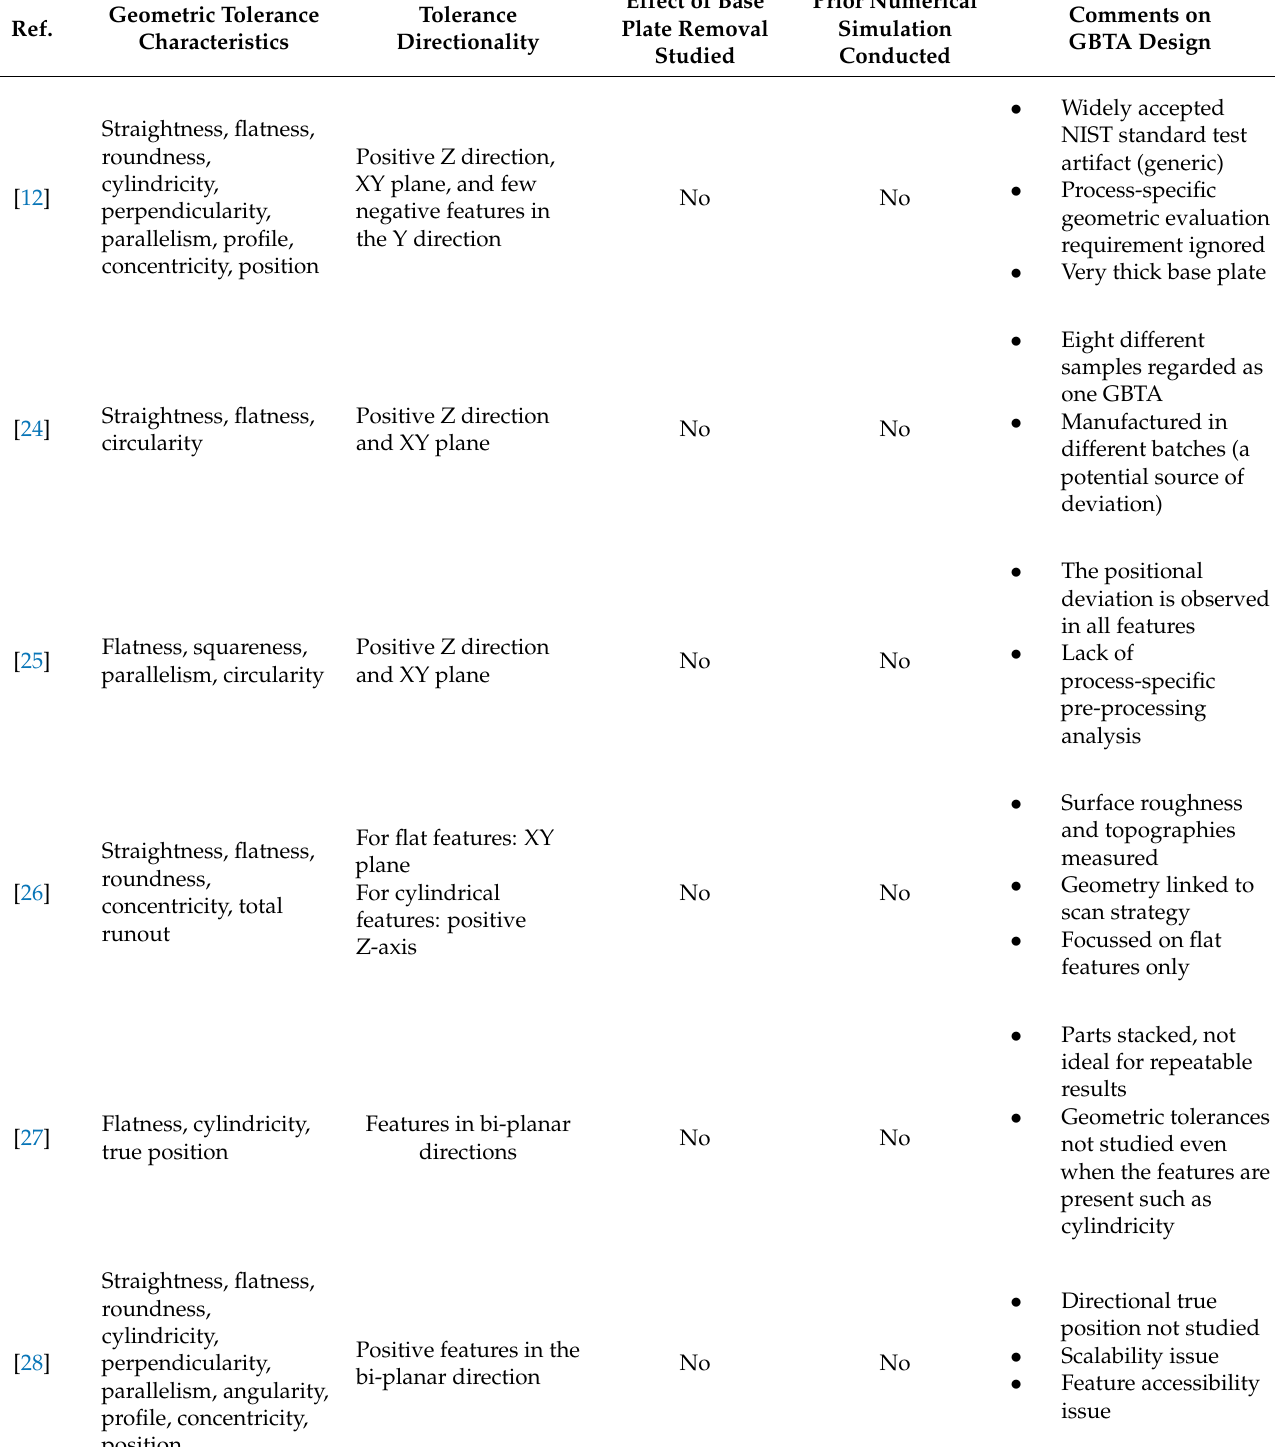
Table 1. Comparison of selected GBTAs according to geometric tolerance characteristics.